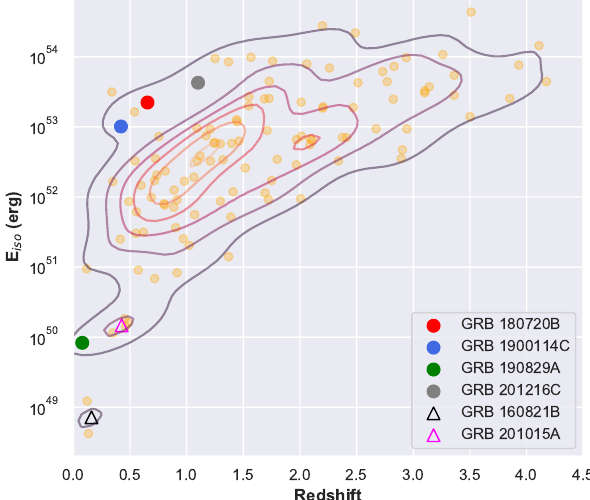
Figure 3. Distribution of the isotropic energy output of the GRBs (in the 50–300keV range) versus the redshift. VHE GRBs are marked with the colored points (sub threshold GRBs are marked with open points), contours show the probability distribution calculated by kernel density